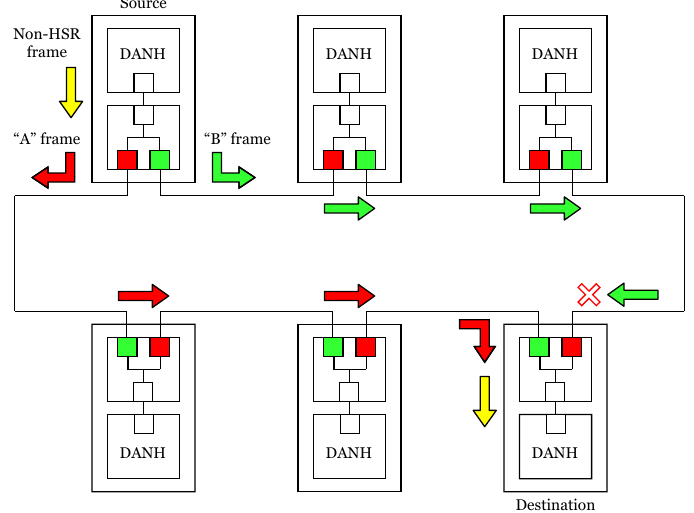
Figure 1. An example of unicast in a single-ring topology